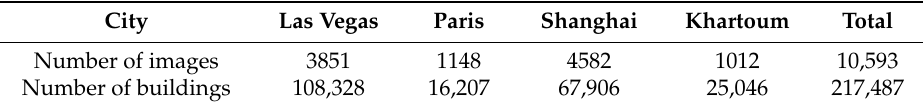
Table 1. Number of image scenes and annotated building footprint polygons of each city. City Las